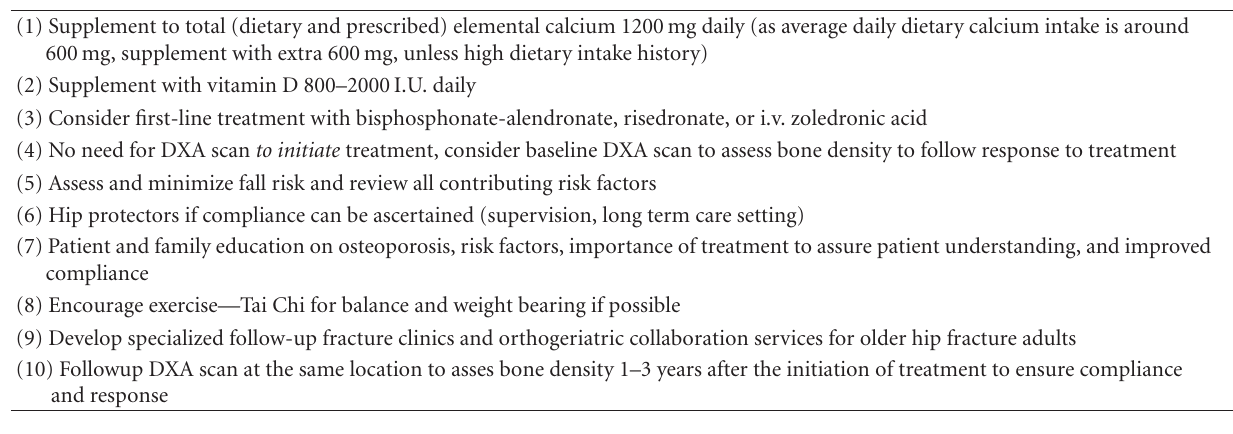
Table 2: Top ten suggested recommendations for all hip fracture patients over age